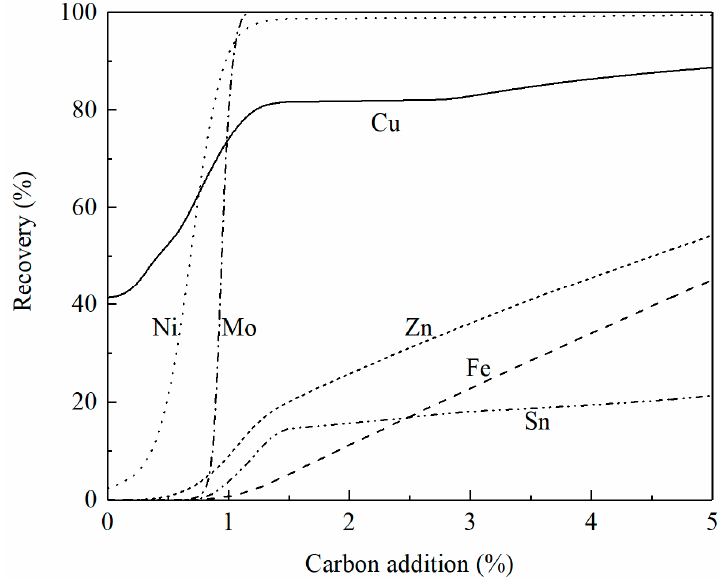
Figure 10. Effect of carbon addition on the recovery of copper, zinc, molybdenum, nickel, iron, and tin from the mixed slag (smelting slag:converting slag = 4:1) at 1250 ° C, calculated by FactSage 8.2.